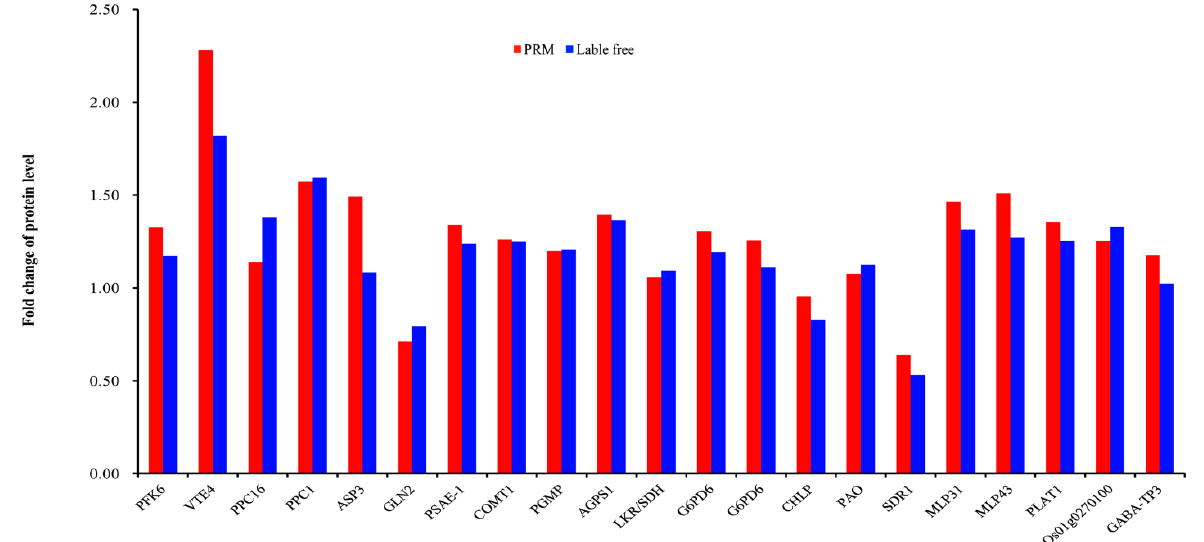
Figure 5. Validation of 21 selected DAPs via parallel reaction monitoring. The ordinate represents the OS6H/NS6H ratio. Abbreviated enzyme names are listed in Table S6.